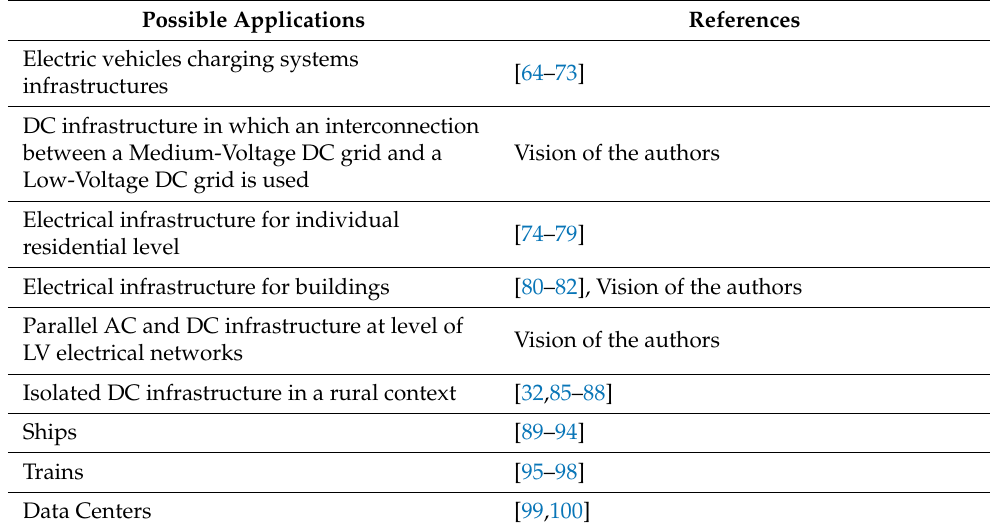
Table 4. Summary of the possible applications of DC microgrids and corresponding references. Possible